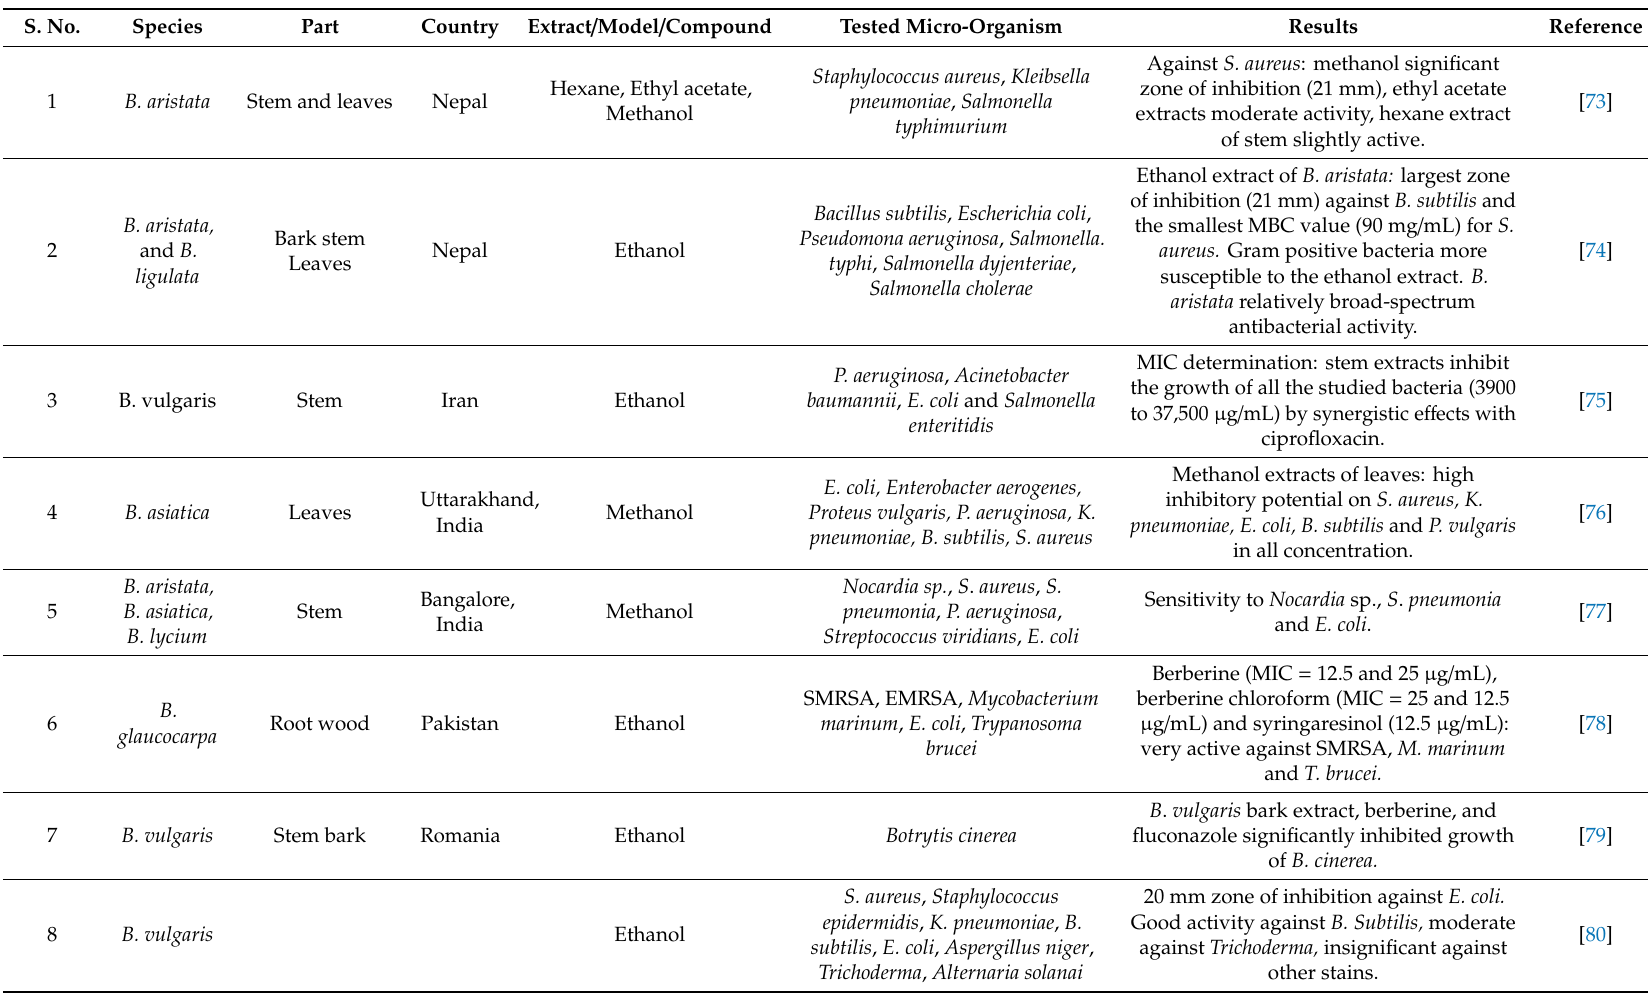
Table 2. A list of the antimicrobial potential of the Berberis species evaluated across the globe is provided which support the use of Berberis species in food preservation. S.